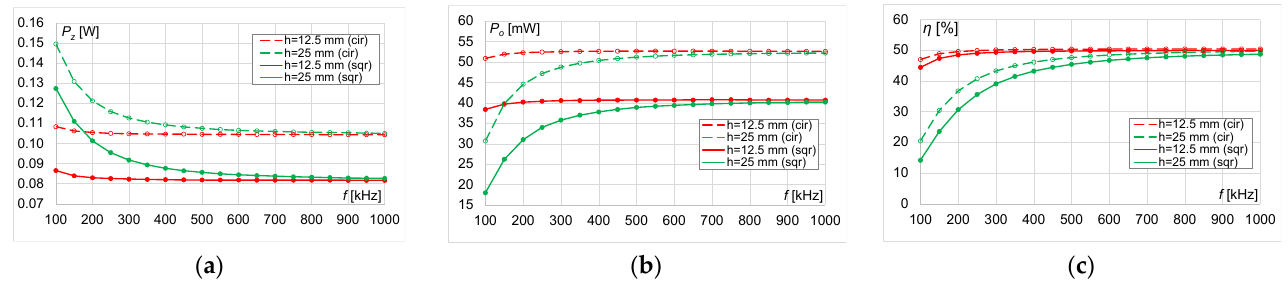
Figure 27. Results for circular and square coils with r = 25 mm and number of turns n = 80 at different distances ( h = 12.5 mm and h = 25 mm): ( a ) transmitter power, ( b ) receiver power and ( c ) power transfer efficiency.